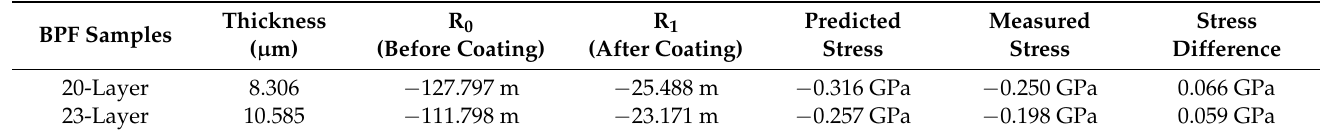
Table 1. Comparison of the predicted and measured stresses in 20-layer and 23-layer MIR-BPFs. BPF Samples